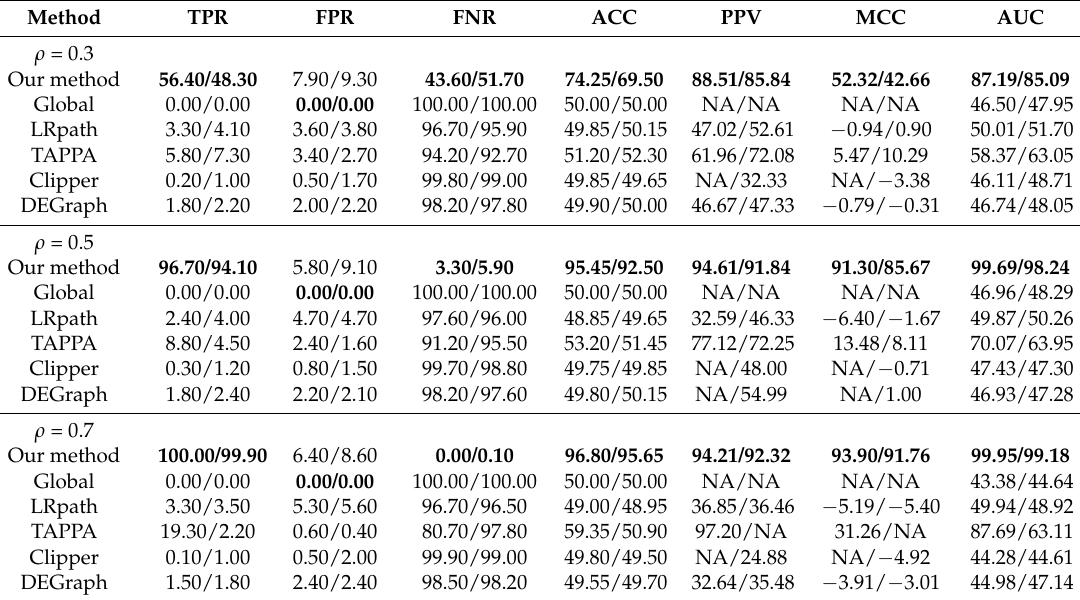
Table 1. Performance comparison (%) of different methods on simulation data with cascade/complex pathway topology and r =